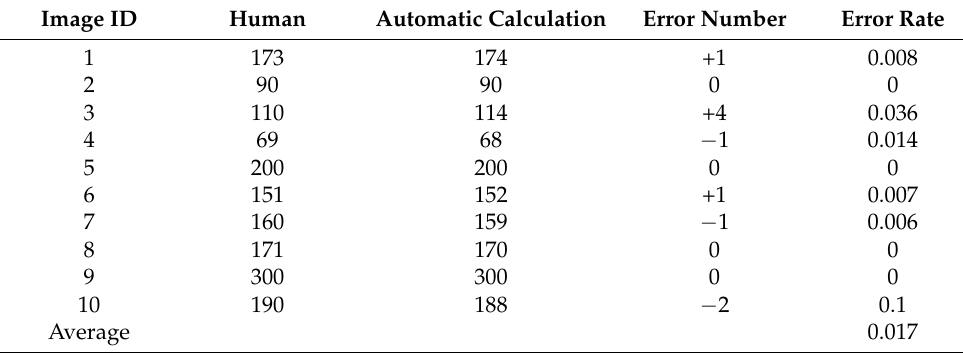
Table 5. Typical metallographic grain number statistics in